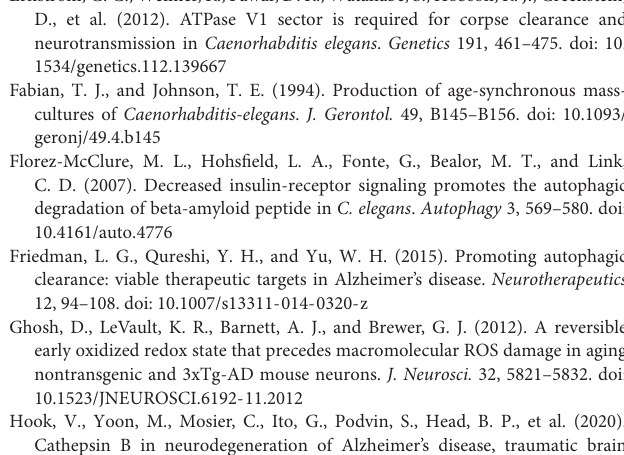
Supplementary Table 1 | The 8 h RNA-seq differential gene data. Supplementary Table 2 | The 24 h differential gene data. Supplementary Table 3 | The proteomic differential protein data. Supplementary Data Sheet 1 | The primer